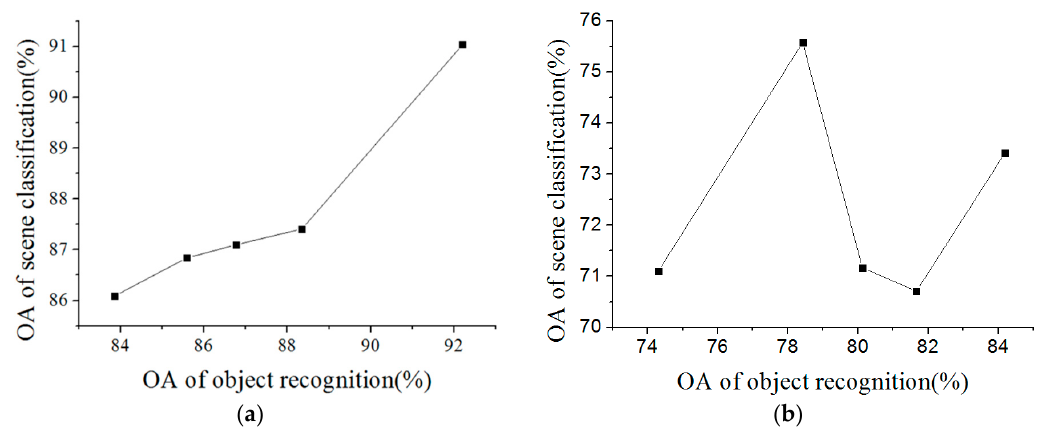
Figure 17. Sensitivity analysis of the land-cover classification accuracy: ( a ) the scene sematic category understanding result for the USGS dataset; and ( b ) the scene sematic category understanding result for the Wuhan IKONOS dataset.